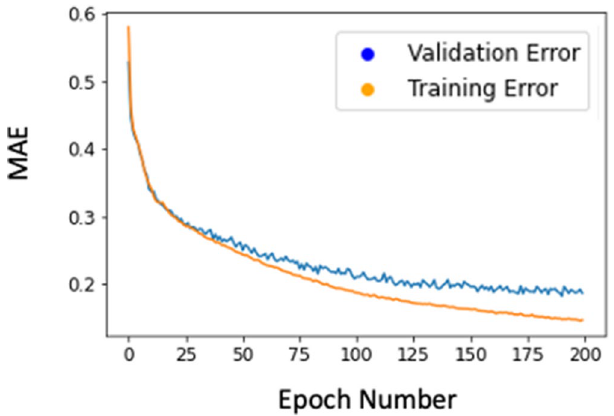
Figure 8. The training and validation errors for the cross-fiber direction. Other outputs had similar